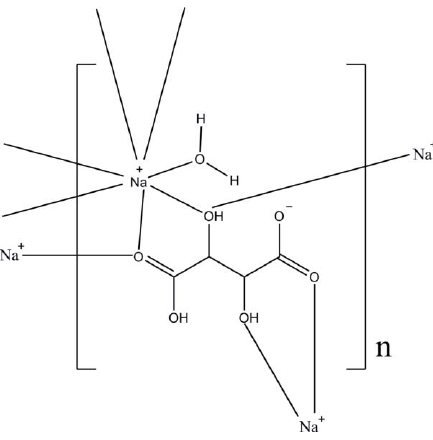
Experimental Crystal data